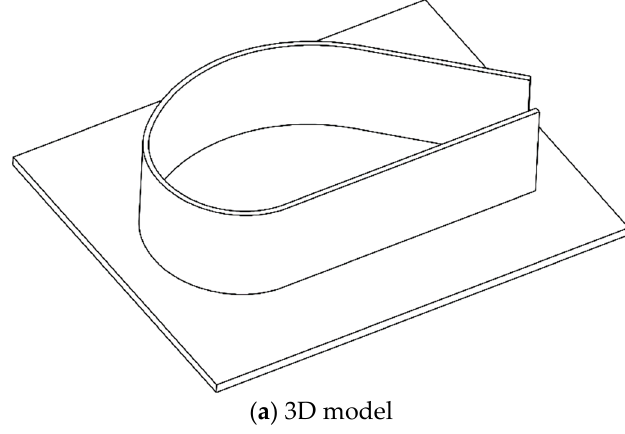
Figure 9. Weld seam coding of welded structure 3.